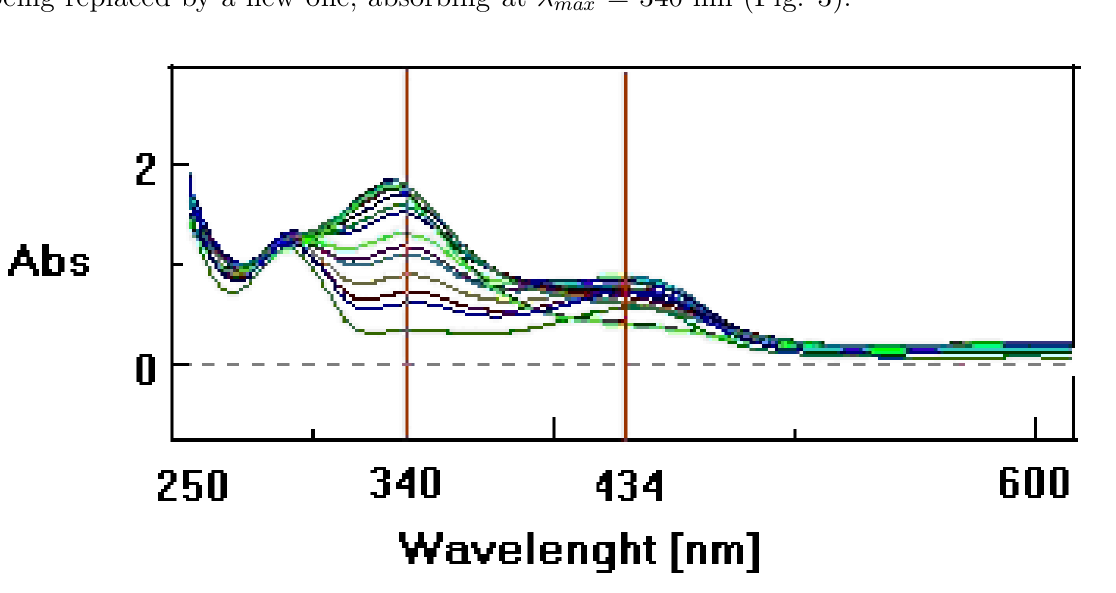
Fig. 3 UV/VIS spectra of the reaction mixture. Conditions: 0.2 M carbonate-bicarbonate bu¬er, pH 9.85, 0.00445 M substrate at 40¸C (1:10 diluted